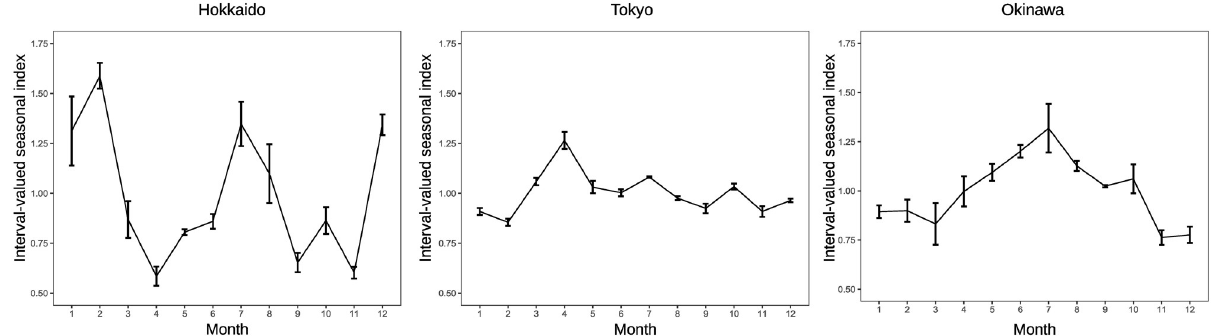
Fig 6. Interval-valued seasonal indices of inbound guests for tourism in Hokkaido, Tokyo and Okinawa.